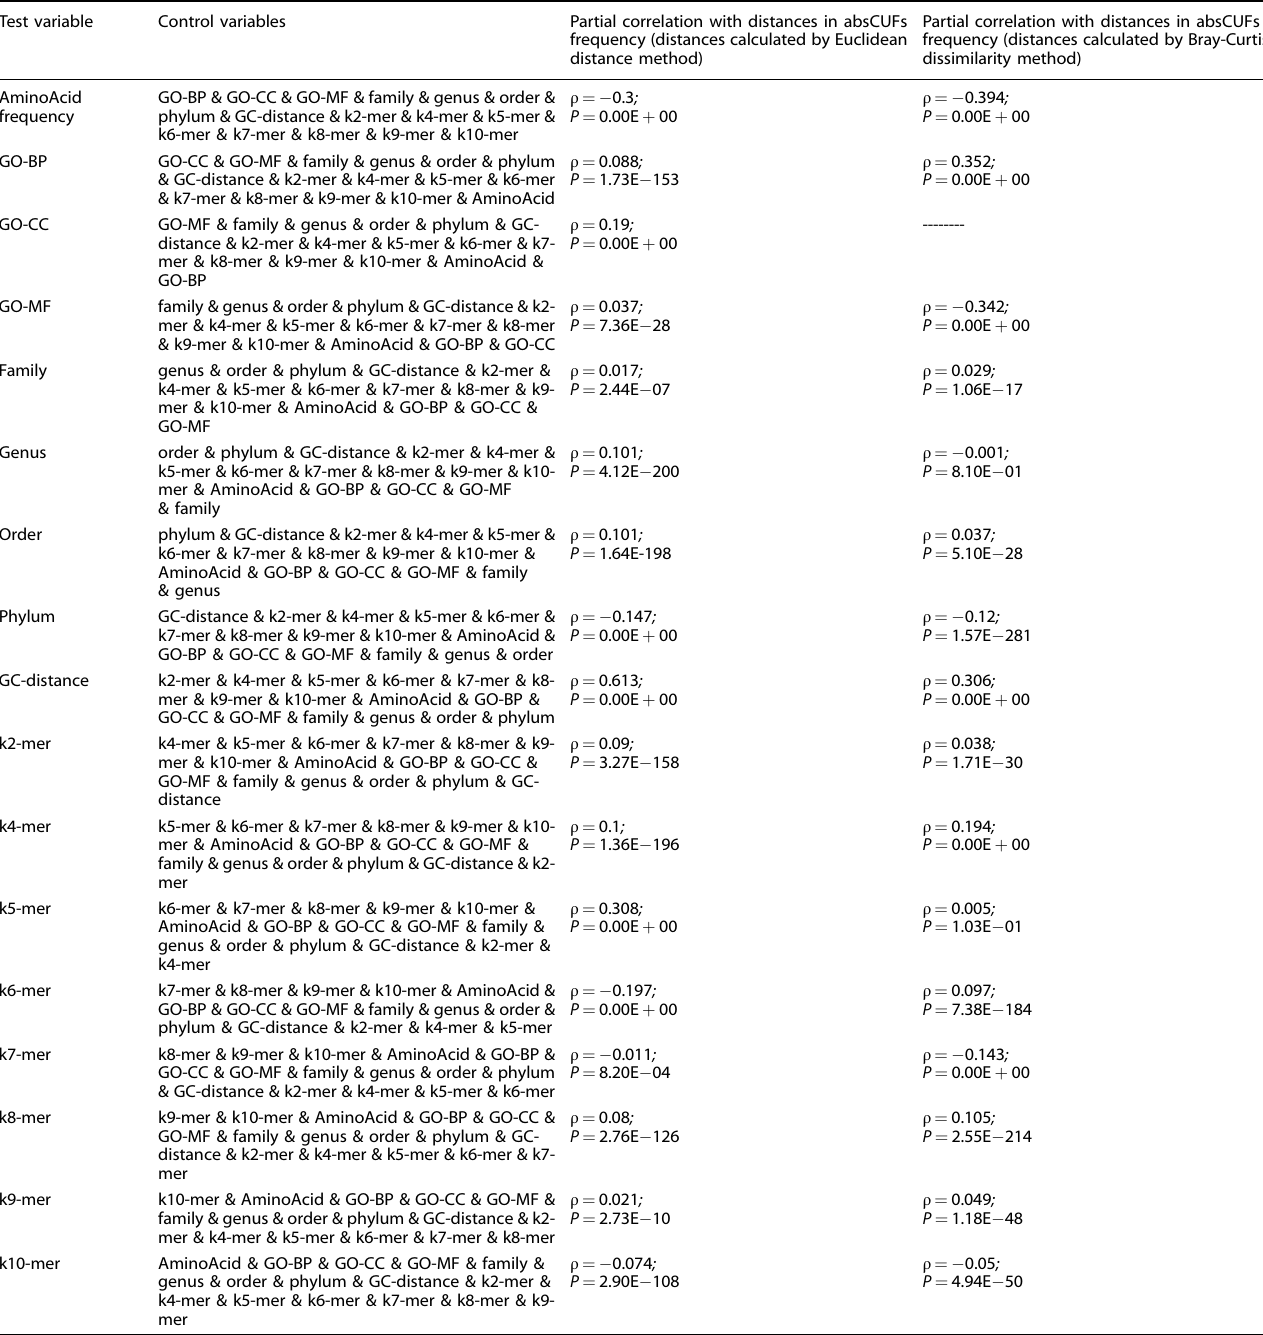
Table 2. Partial correlation analyses between the distances in codon usage frequencies and distances of all other variables. Test